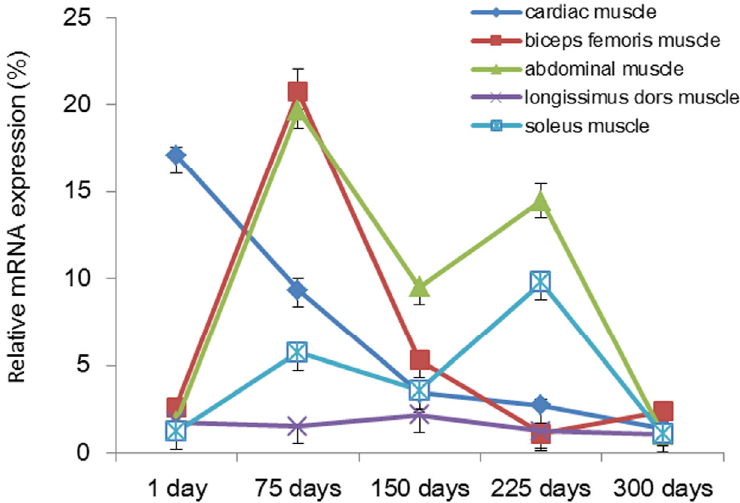
Figure 7. Temporal mRNA expression profiles of PPP3CA during different muscle development in Tianfu goat. Bars represent the mean ± SD ( n = 8).